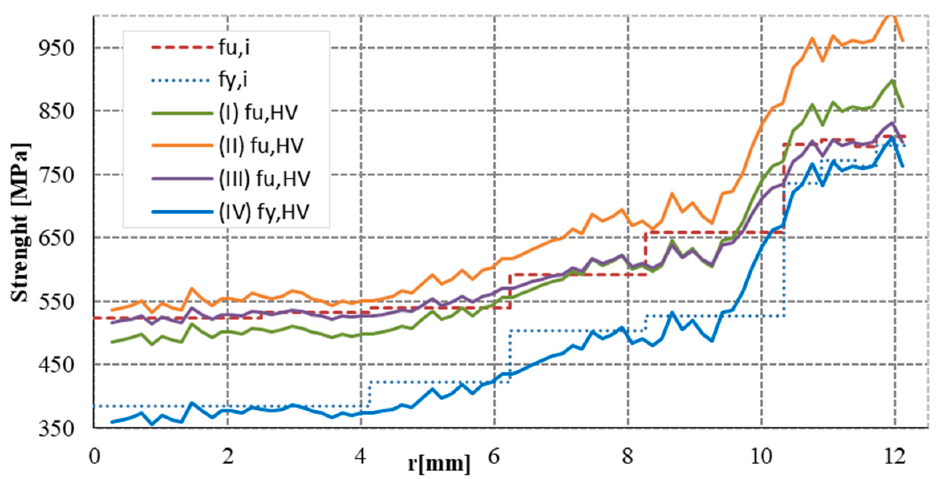
Figure 11. Tensile and yield strength as a correlation from hardness test across the bar ( φ 25 mm). Table 4. Comparison of mechanical properties as a function of hardness and tensile testing.